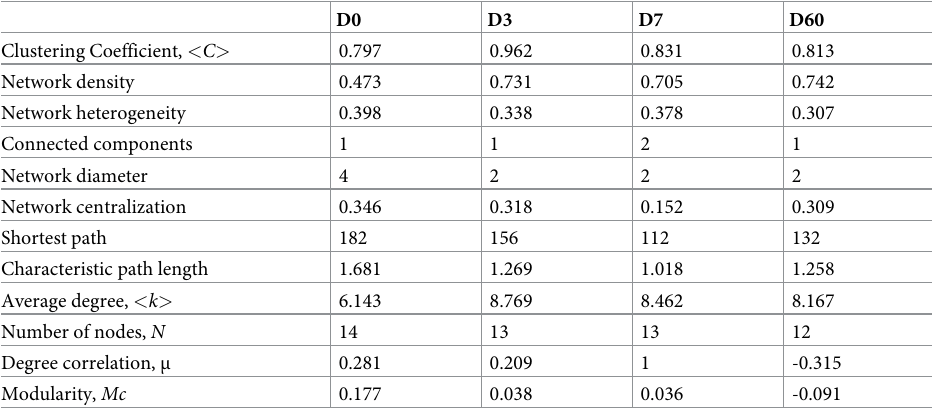
Table 3. Network topological parameters of D0, D3, D7, and D60 after transarterial chemotherapy.